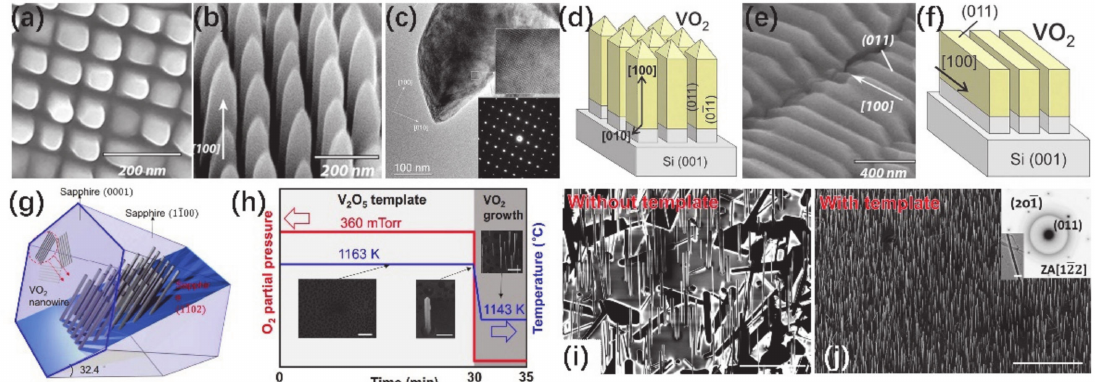
Figure 12. ( a , b ) SEM images of an ordered array of free-standing VO 2 NWs from different perspectives. ( c ) TEM image of a VO 2 NW and the corresponding SAED pattern. ( d ) Schematic diagram of the VO 2 NWA grown on Si substrate. ( e ) SEM image of an ordered array of VO 2 nanowalls and ( f ) a schematic diagram of an array of VO 2 nanowalls. Reproduced from [85], with permission from AIP Publishing, 2018. ( g ) Diagram of the relative crystal orientation of the hexagonal prism of VO 2 NW and sapphire crystal. ( h ) The design schematic diagram of the two-stage growth of VO 2 nanoforest by controlling the oxygen pressure and substrate temperature with V 2 O 5 droplets as template; the insets show SEM images of products at different growth stages. SEM of VO 2 grown ( i ) without and ( j ) with V 2 O 5 template. Reproduced from [86], with permission from American Association for the Advancement of Science,